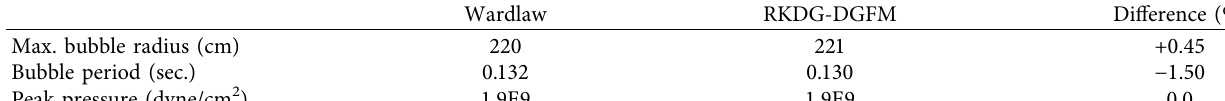
Figure 18: RKDG-DGFM results of Case 5 at 0.15 seconds. Table 2: Comparison between simulations performed by RKDG-DGFM solver and Wardlaw.